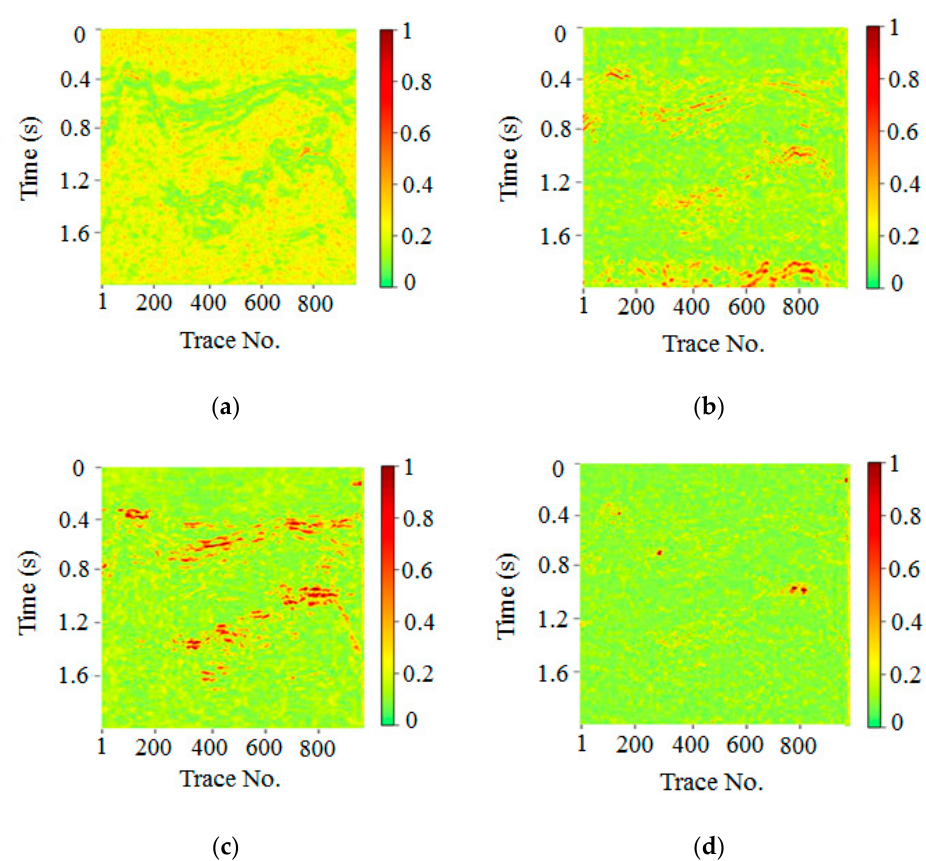
Figure 13. Local similarity comparison of real data. Local similarity map of ( a ) FXDECON, ( b ) MSSA, ( c ) wavelet transform, and ( d ) the proposed method.